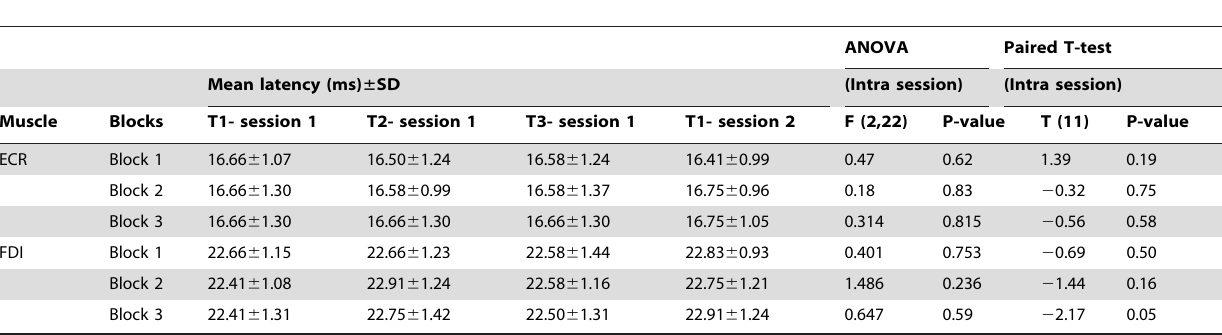
Table 2. Mean, standard deviation and level of agreement of MEPs latency for three blocks of trials recorded from ECR and FDI muscles.